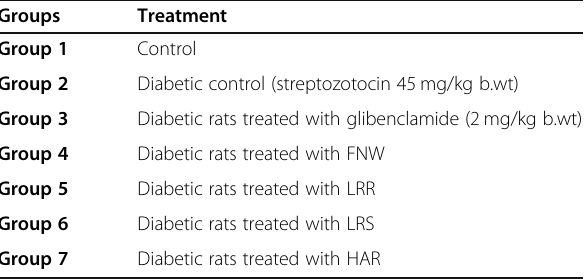
Table 2 Experimental design for in vivo anti-diabetic study Groups